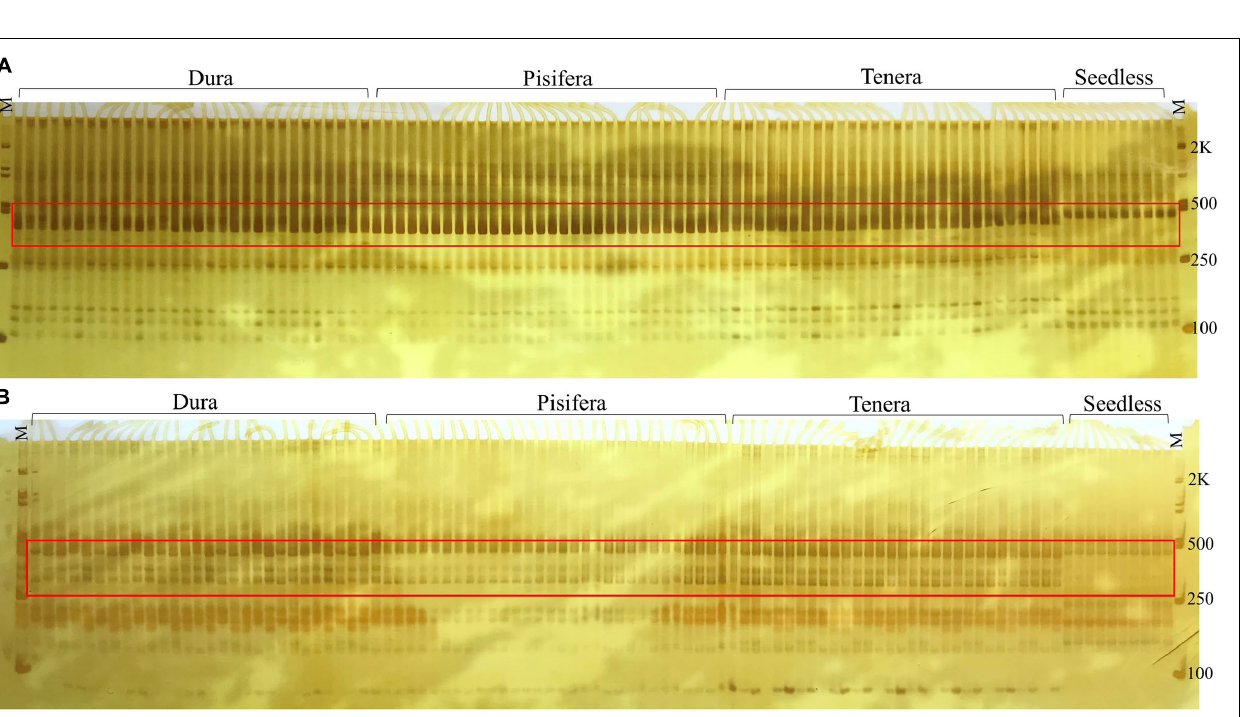
FIGURE 12 | Markers (A) S41 and (B) S44 showed distinction between seedless and seeded (Dura, Pisifera, and Tenera) palm trees, where M represents 100-bp marker.